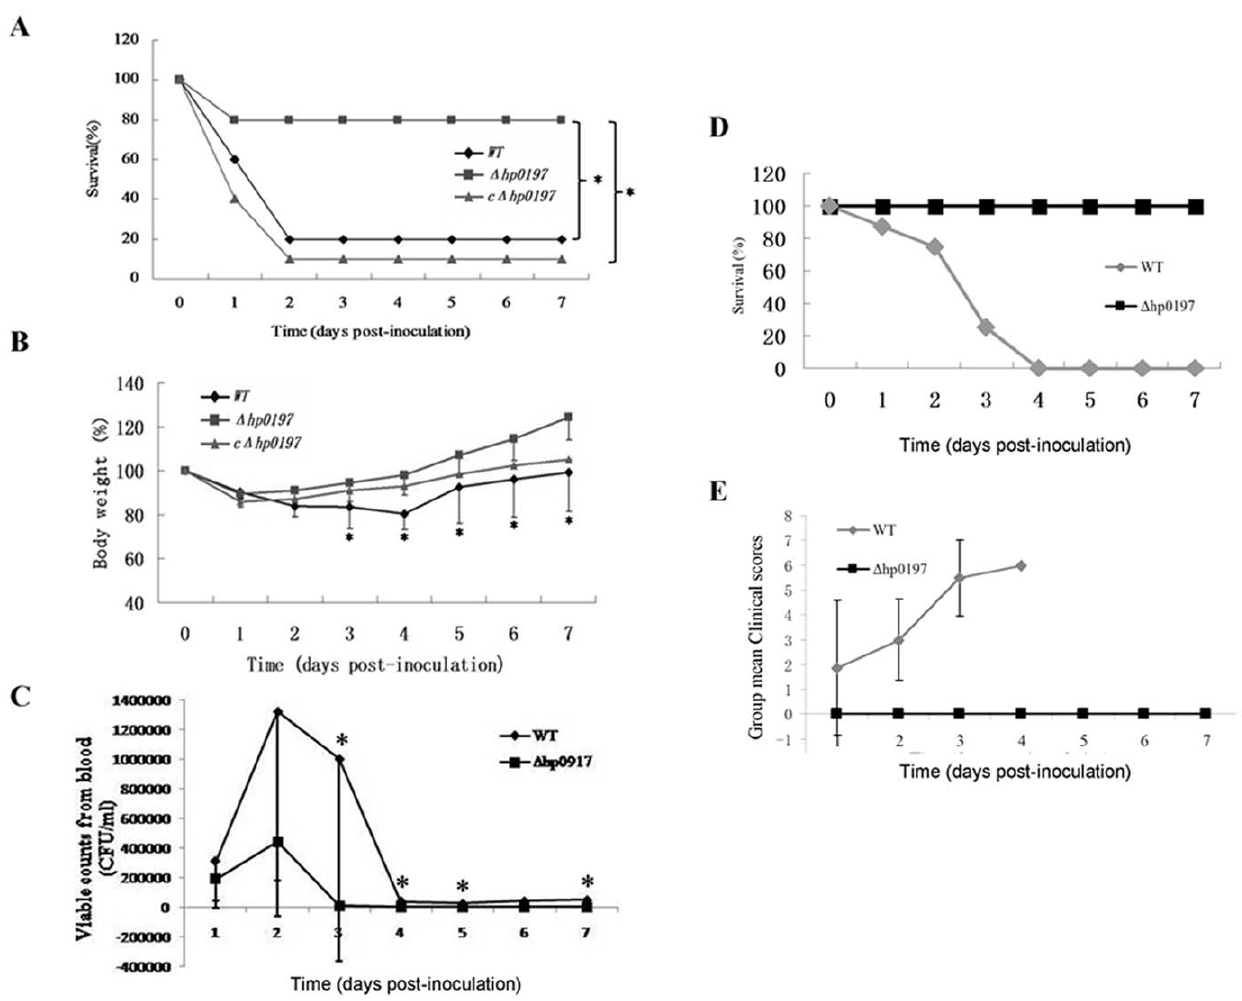
Figure 2. HP0197 contributes significantly to S.suis virulence in mice and pigs. ( A ) The survival of experimental mice inoculated with WT, D hp0197 and c D hp0197 strains. Ten mice in each group were inoculated by intraperitoneal injection with 10 9 CFU of WT, D hp0197 or c D hp0197 respectively and the mice were monitored for clinical signs of infection three times a day during 7 days. ‘‘*’’ represents P value , 0.05 of WT versus D hp0197 group or D hp0197 versus c D hp0197 group respectively. ( B ) The loss of body weight of mice inoculated with the WT, D hp0197 and c D hp0197 strains, which usually reflects the health status of mice. ‘‘*’’ represents P value , 0.05 of WT versus D hp0197 group. ( C ) The kinetics of bacterial clearance from the blood of mice inoculated with the WT, D hp0197 and c D hp0197 strains. ‘‘*’’ represents P , 0.05 of WT versus D hp0197 group at given time course. ( D ) The survival of experimental pigs inoculated with WT and D hp0197 strains. Eight pigs in each group were inoculated intranasally with 2 6 10 7 CFU of WT and D hp0197 strains respectively. Four pigs were inoculated with PBS and served as a control. ‘‘*’’ represents P , 0.05 of WT versus D hp0197 group. ( E ) Clinical scores (daily means and standard deviations) of pigs after inoculation. ‘‘*’’ represents P value , 0.05 of WT versus D hp0197 group at given time